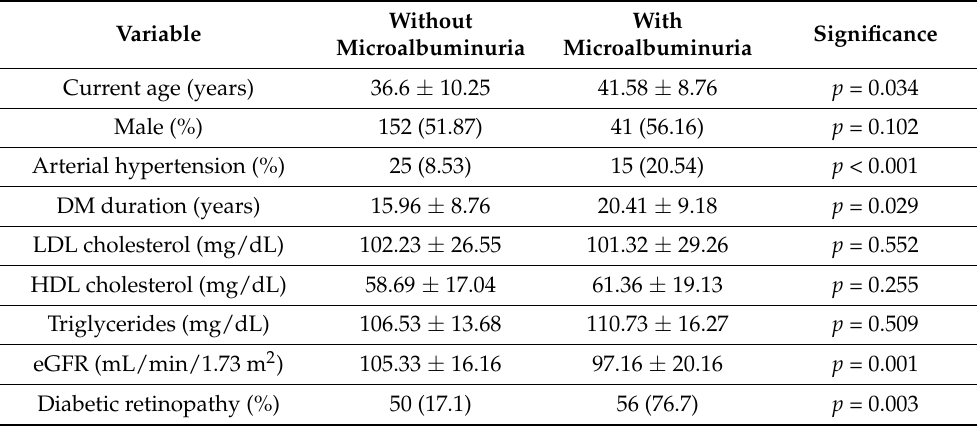
Table 3. Univariate study of microalbuminuria.